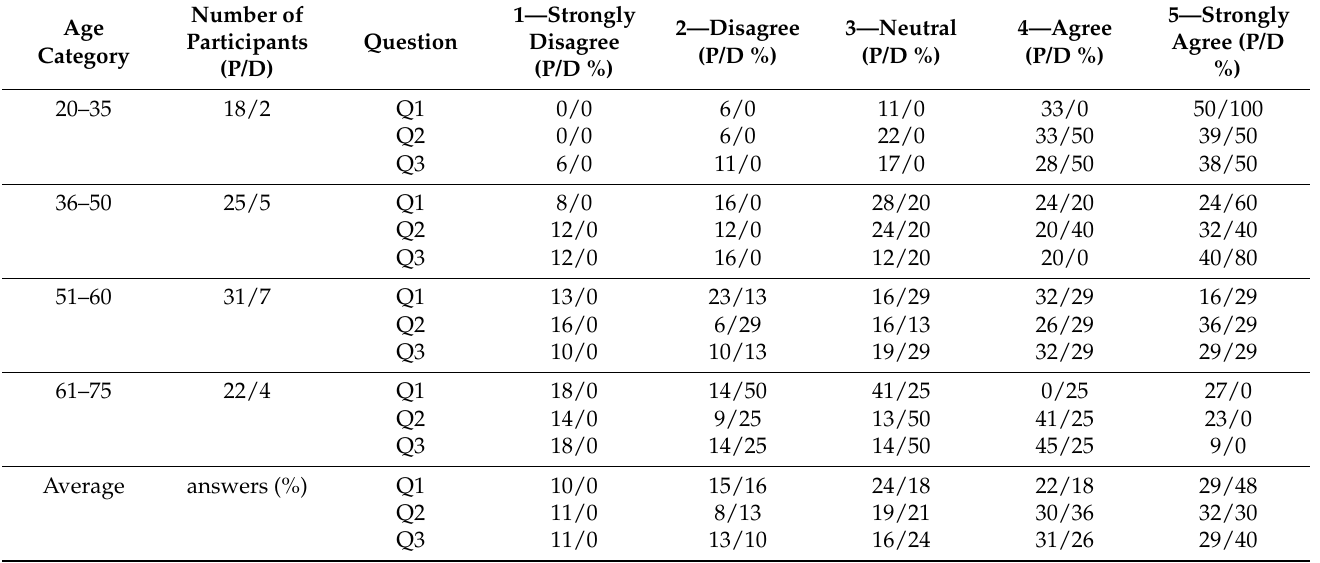
Table 2. The results of the survey regarding the potential patients/users and doctors based on age categories that replied in percentage